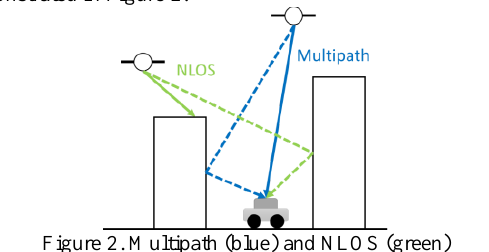
Figure 2. Multipath (blue) and NLOS (green)